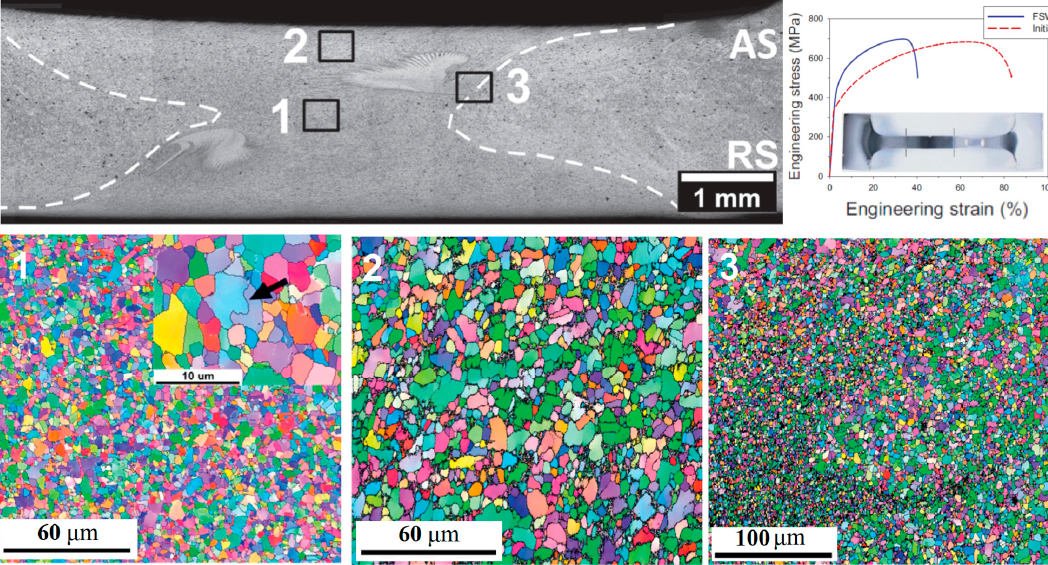
Figure 9. Grain size in three different regions of CoCrFeMnNi alloy welded by FSW and mechanical properties. Adapted from [36].